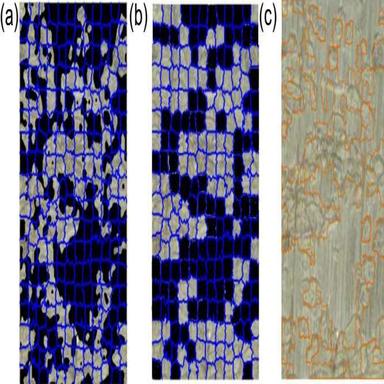
a) The reinforcing elements and the composite basis based on the generated super-pixels; (b) The final reinforcing elements (original image regions) are distinguished from the base matrix (black regions); (c) contours (orange lines) of reinforcing elements in the microscopic image.